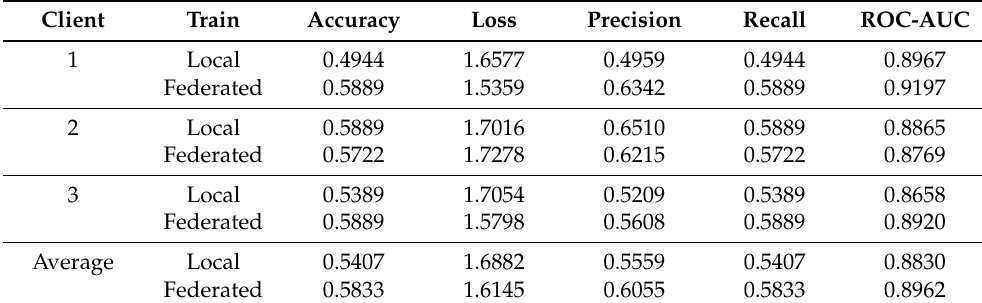
Table 5. Model training results for scenario